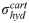
Obtained stress, tensile strain and patella shape.Up: Hydrostatic stress distribution on the tendon at different angles 30°, 45°, 60°, 90° and 110°. The value of the hydrostatic pressure was projected on the 90° domain for comparison. Middle: principal tensile strain for 30°, 45°, 60°, 90° and 110°. Bottom: the obtained patella shape, where the elements that have the hydrostatic stress above the tissue differentiation threshold σhydcart.